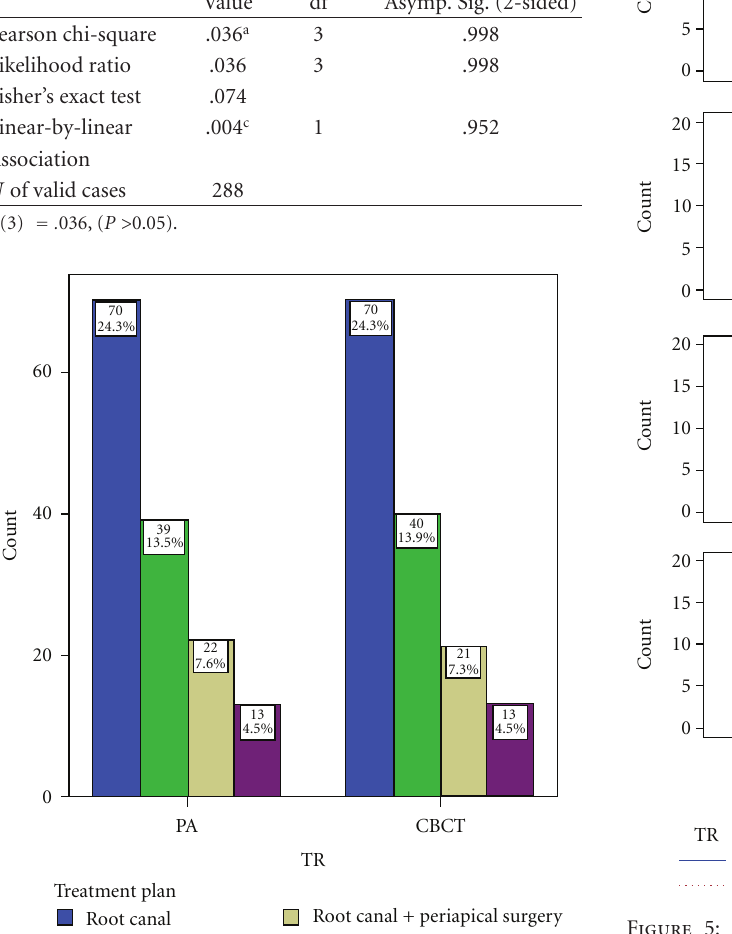
Figure 5: Graph showing trend among observers in selecting treatment decisions among the imaging modalities (PA and